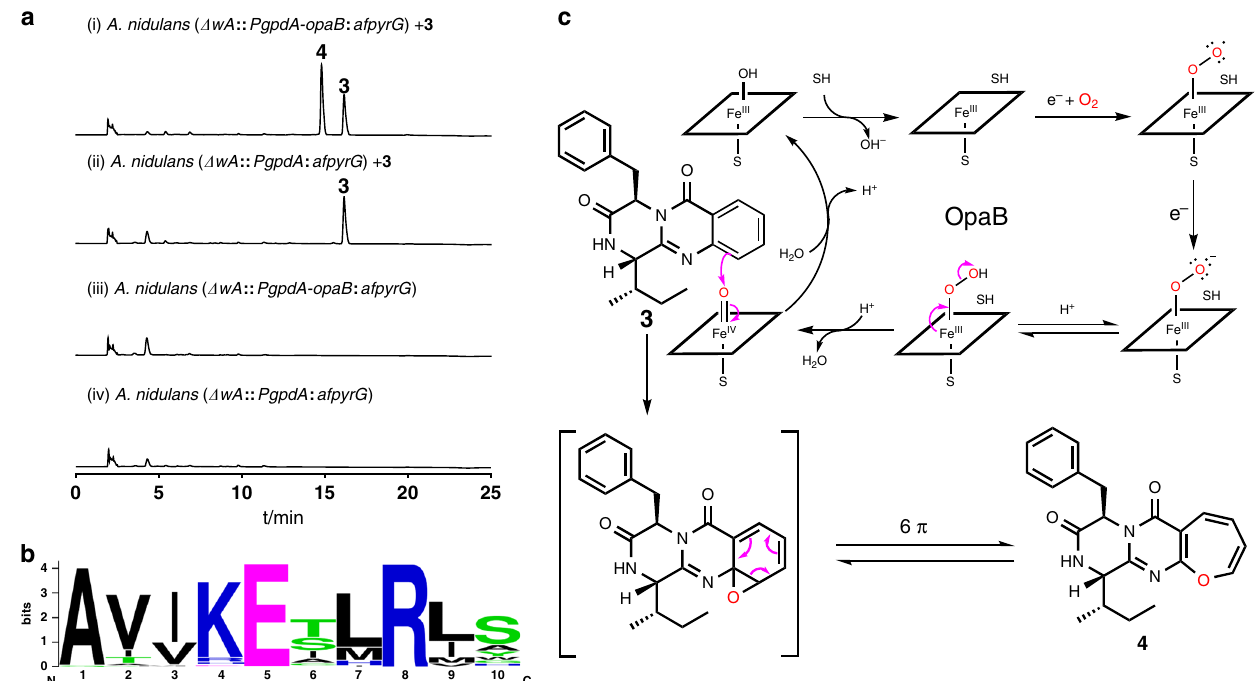
Fig. 3 Functional veri fi cation of the oxepinase OpaB. a HPLC analysis of the conversion of 3 to 4 in the opaB expression strain of A. nidulans at 254 nm. b A sequence logo for the conserved EXXR motif in OpaB using sequences of 96 P450 enzymes (Supplementary Table 9). c Proposed mechanism for oxepin formation catalyzed by OpaB (SH: